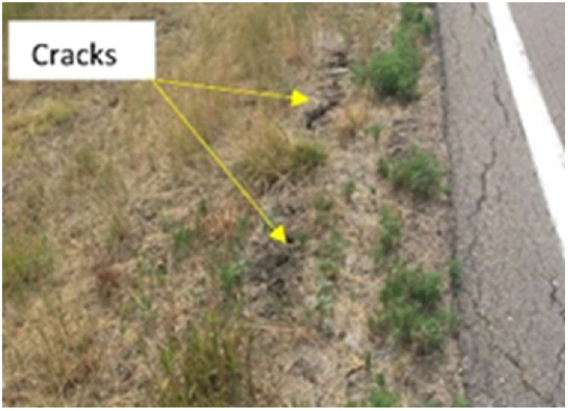
Figure 7. Initial Cracks Appeared on Highway 84.